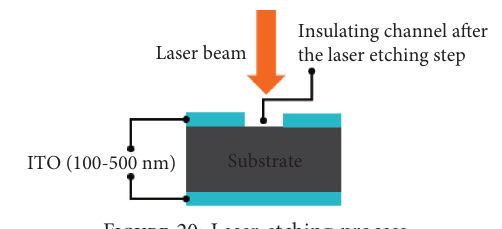
Figure 20: Laser etching process.